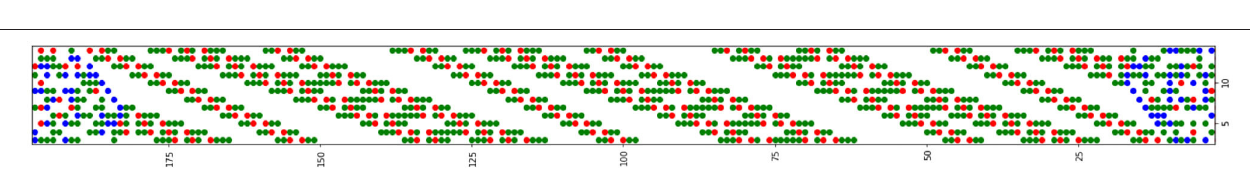
FIGURE 3 | The identity of the sandpile group on a skewed cylinder is presented, that is, we took the standard lattice in the rectangle [0,200] × [0,12] and identified each point ( x ,0) with ( x + 5,12) for x ∈ [0,195]. Let sinks be the vertices with less than four neighbors. The picture presents the identity of the sandpile group of this graph. White is three, green is two, red is one, and blue is zero. If we would take a flat cylinder, i.e., we would identify ( x ,0) with ( x ,12), then, in the picture for the identity of the sandpile group, we would have 3 everywhere except several green vertical lines, i.e., columns with two